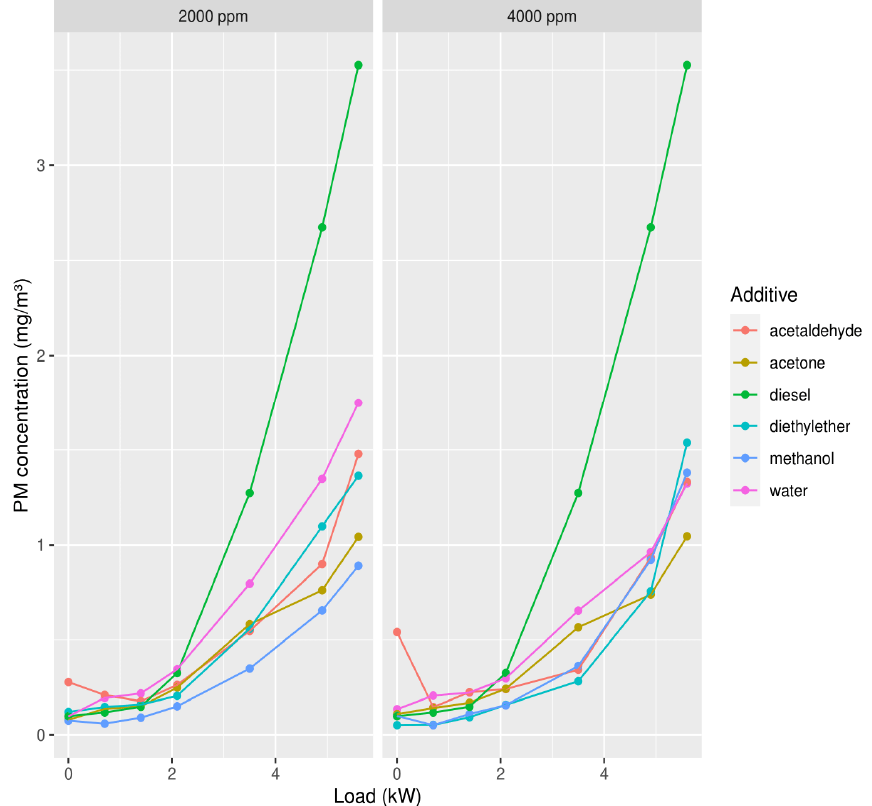
Figure 4. Concentrations of PM in the exhaust gas in function of the load, with 2000 ppm ( left column ) or 4000 ppm ( right column ) of each of the oxygenates added to the diesel.